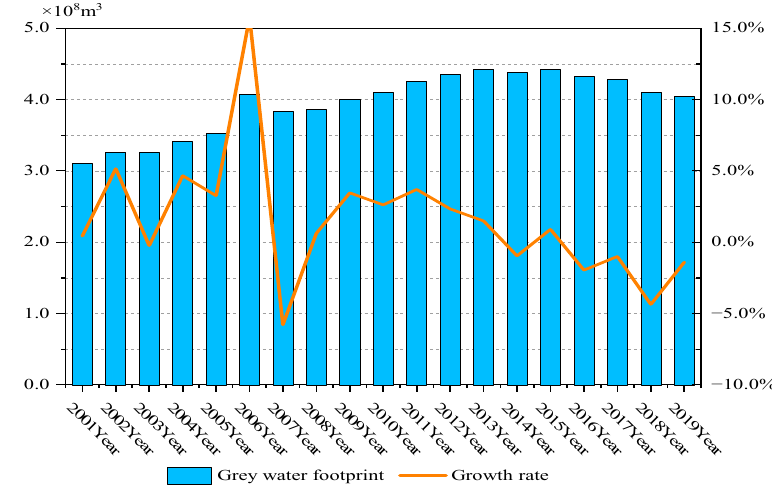
Figure 2. The overall evolution trend of AWF grey in the Yellow River Basin.